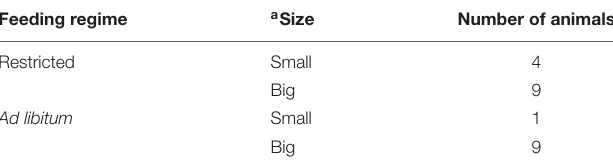
TABLE 2 | Distribution of animals in groups according to feeding regime and